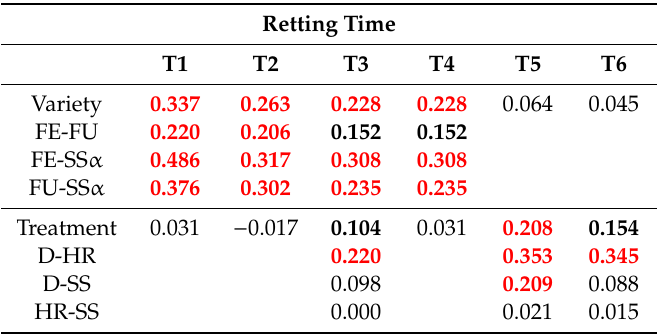
Figure 1. Alpha diversity ( a ) Observed richness and Shannon diversity by variety ( b ) Observed richness and Shannon diversity by treatment. Lines connecting box plots indicate significant difference using Wilcoxon each-pair signed-rank text, α = 0.05. Table 1. ANOSIM comparisons over time by variety and treatment 1